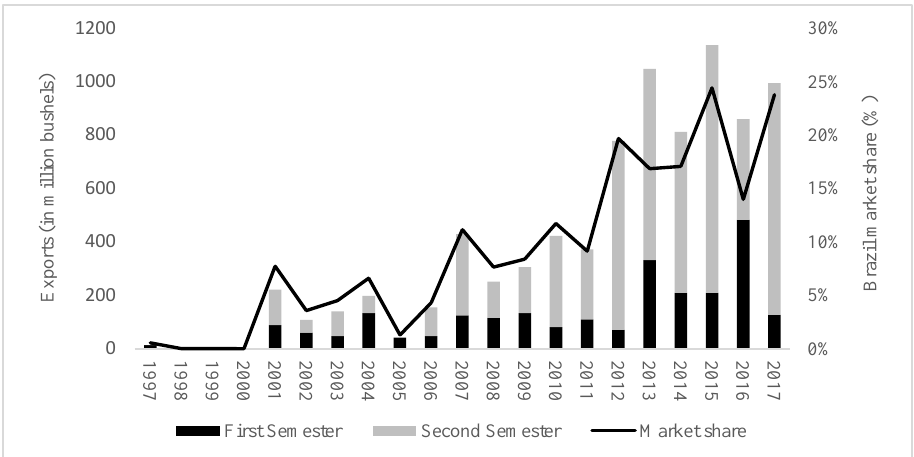
Figure 2. Brazilian corn exports and world market share between 1997 and 2017. Source: SECEX (Brazil’s Foreign Trade Bureau) and USDA.